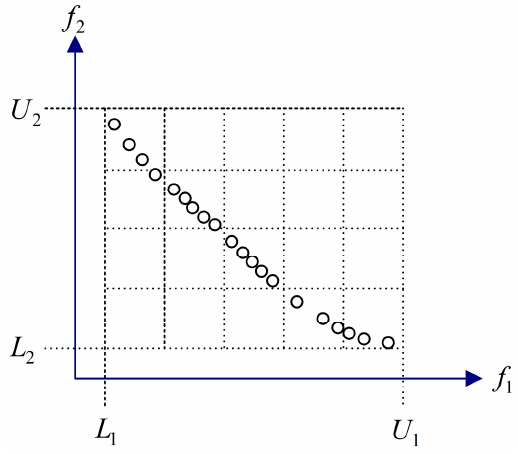
Figure 4. Topographical knowledge.